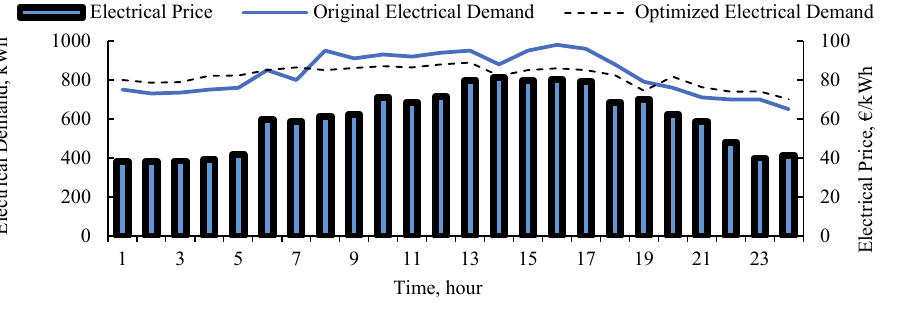
Fig. 5. Original and optimized electrical demand.